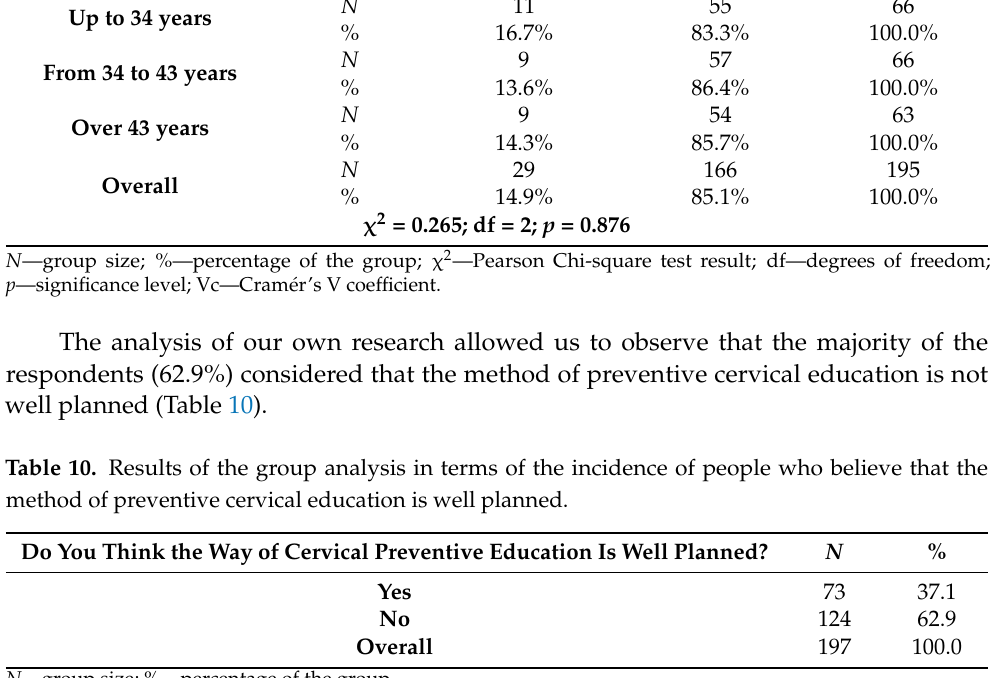
Table 9. Results from analyzing the relationship between the age of the respondents and the practice of anal sex. Do You Practice Anal Sex? Age Total Yes No N 11 55 66 Up to 34 years % 16.7% 83.3% 100.0% N 9 57 66 From 34 to 43 years % 13.6% 86.4% 100.0% N 9 54 63 Over 43 years % 14.3% 85.7% 100.0% N 29 166 195 Overall % 14.9% 85.1% 100.0% χ 2 = 0.265; df = 2; p = 0.876